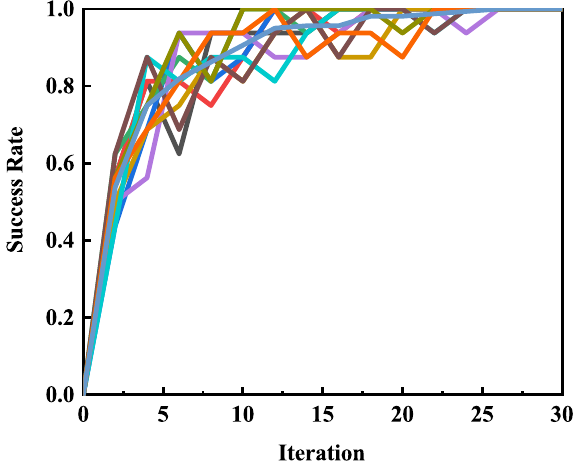
Figure 5. The relationship between success rate and iterations.